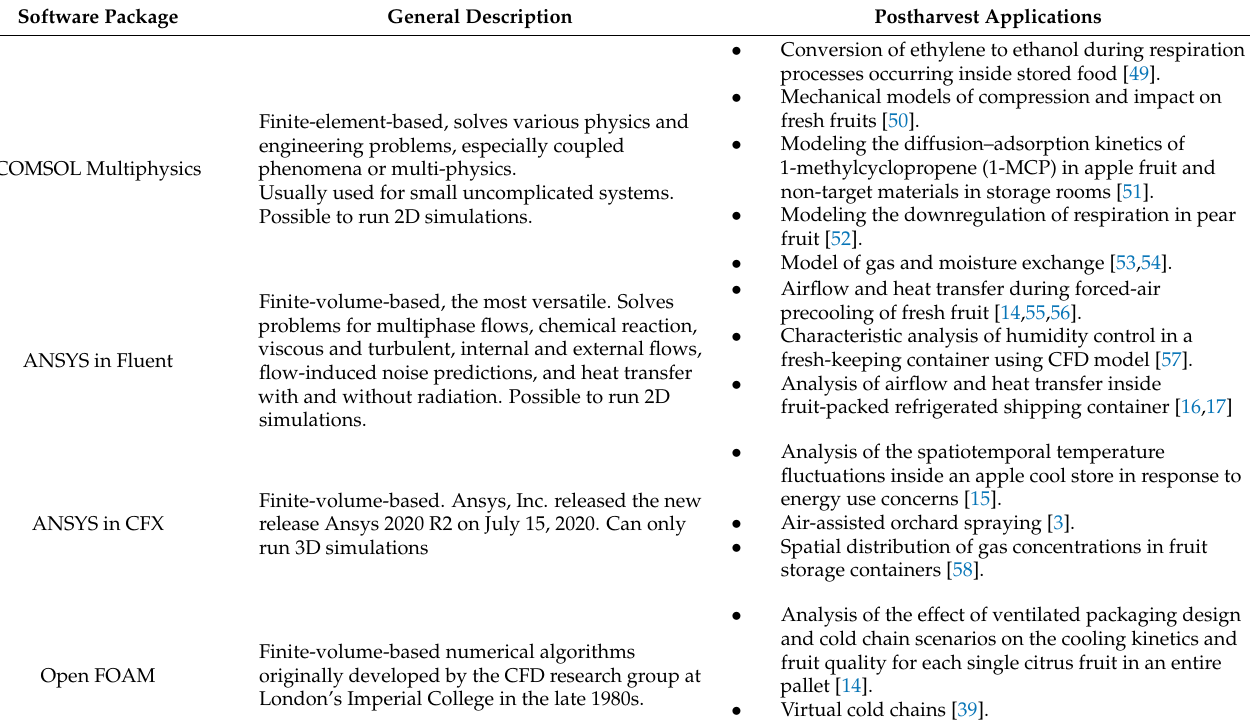
Table 1. The most used general-purpose codes in the postharvest computational fluid dynamics application. Software